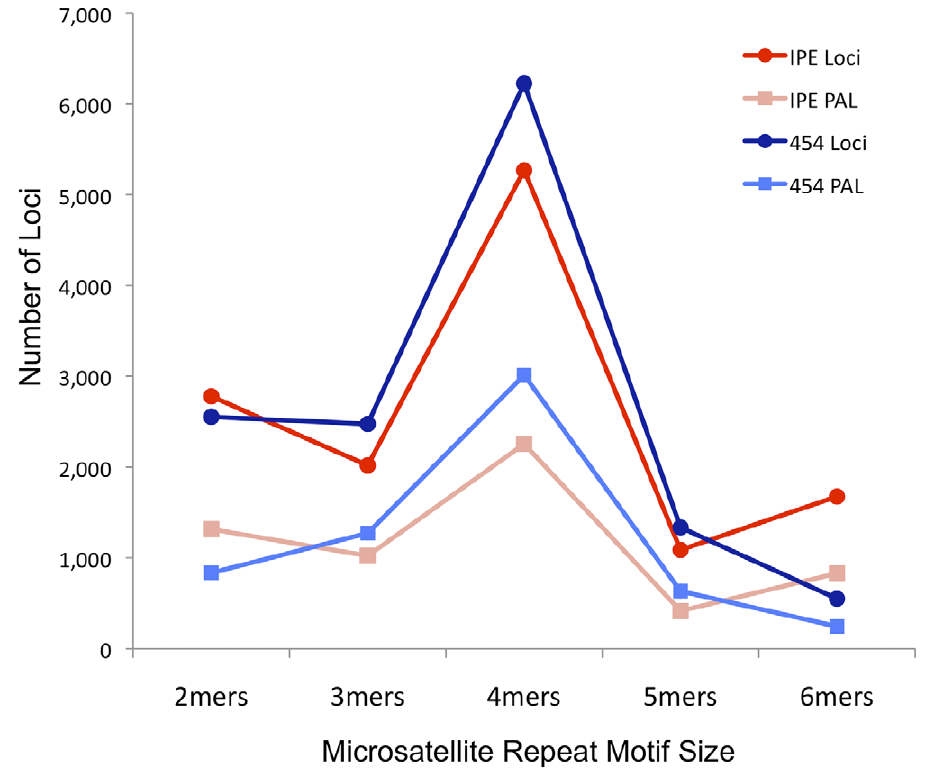
Figure 1. Comparison of identification of microsatellite loci and ‘potentially amplifiable microsatellite loci’ (PAL) using Illumina long (114 bp) paired-end reads versus 454 reads. Comparison based on the same number of reads for each platform (118,973 reads) sampled from Burmese python shotgun genomic libraries.